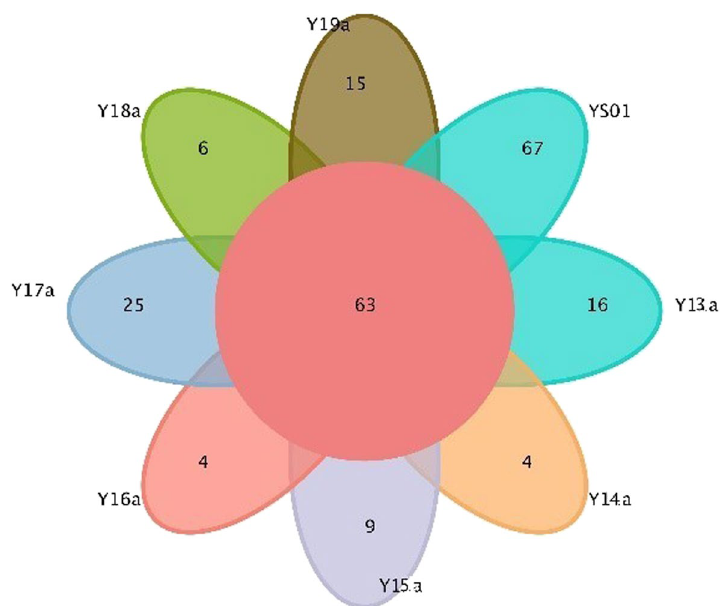
Fig. 2 Venn diagram of bacterial operational taxonomic unit distribution in the sample